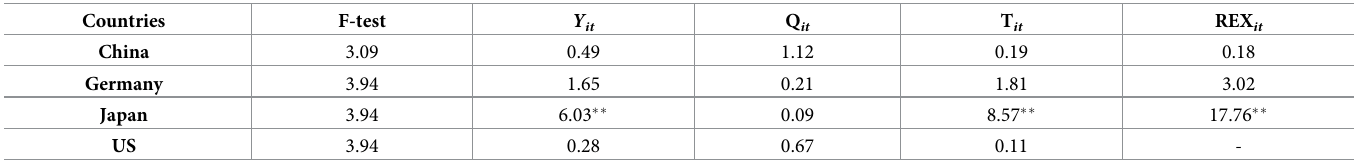
Note �� indicates significance at 5% level of